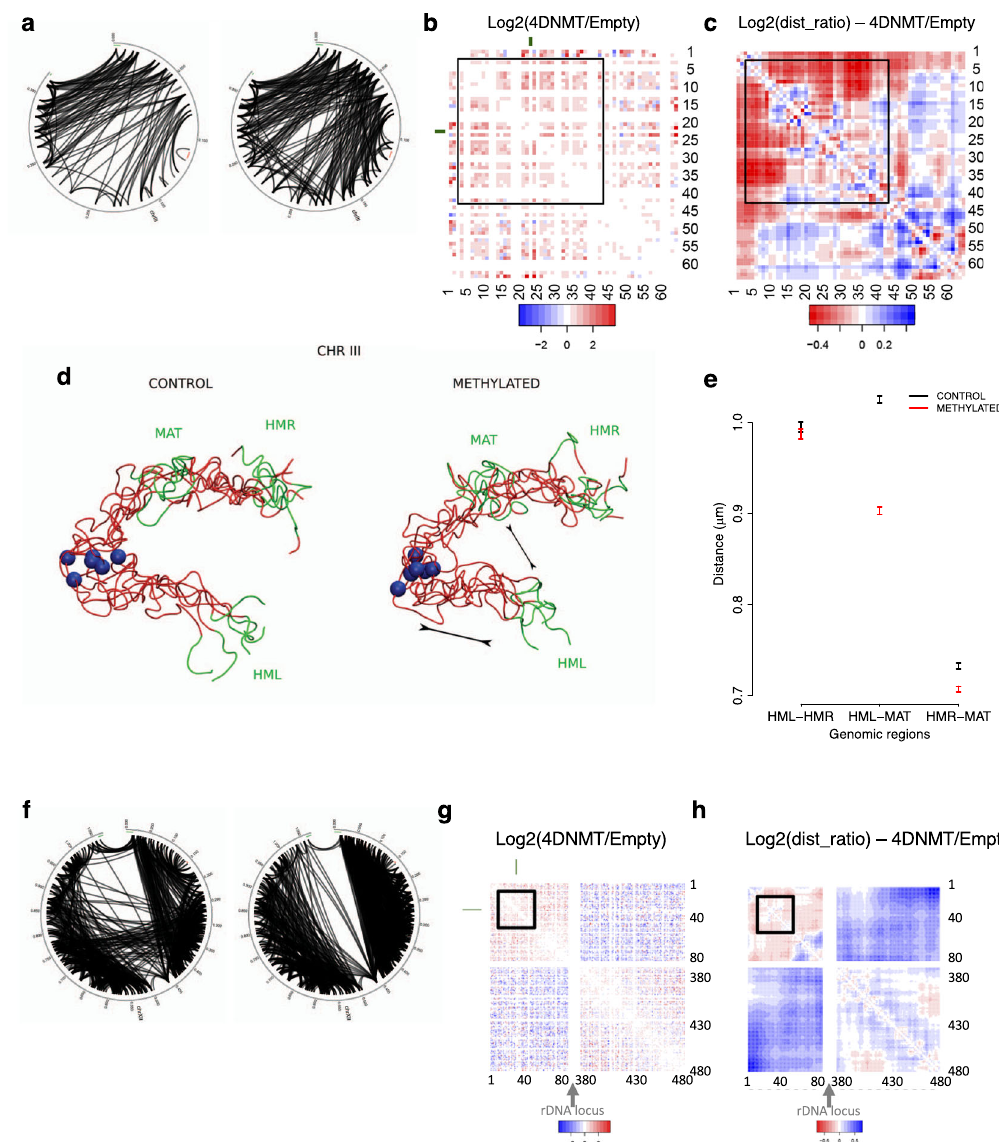
Fig. 7 Chromosome conformation changes under DNA methylation. a Circos diagrams of signi fi cant interactions in chromosome III for the control (left) and methylated (right) samples. Heatmaps displaying the log2 ratio (Methylated/Control) of ( b ) the contact frequencies and ( c ) the distances in the ensemble for chromosome III. Blue indicates interaction with a higher frequency or shorter distance in the non-methylated control sample and red indicates interactions with a higher frequency or shorter distance in the methylated samples. d 3D representative structures for chromosome III highlighting the distance between MAT and HML loci shown in green. The centromere is represented as a blue sphere. e Average distances (±standard error) between mating type loci in the ensemble of structures for chromosome III ( n = 260 and 482 structures for control and methylated samples, respectively). f Circos diagrams of signi fi cant interactions in chromosome XII for the control (left) and methylated (right) samples. Log2 ratio (Methylated/Control) of ( g ) the contact frequencies and ( h ) the distances in the ensemble for chromosome